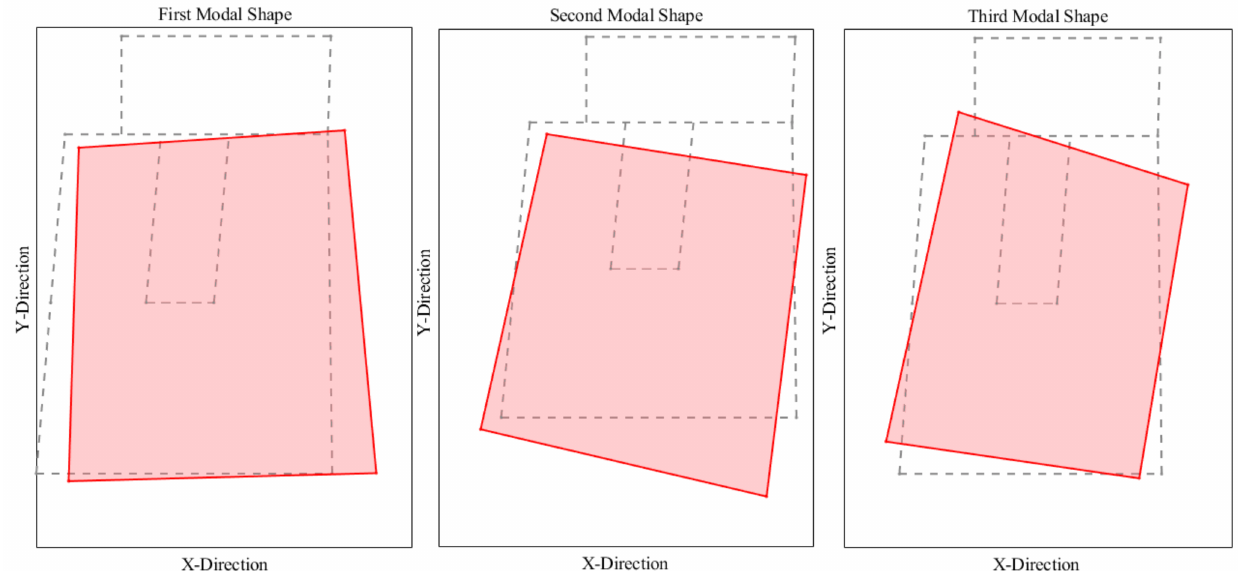
Figure 11. Experimental mode